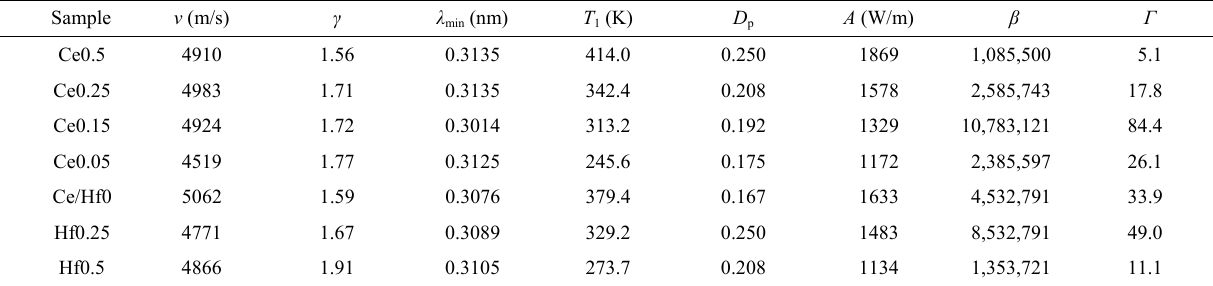
Table 4 Physical properties and fitting parameters A , β , and Г of A 2 B 2 O 7 high-entropy ceramics Sample